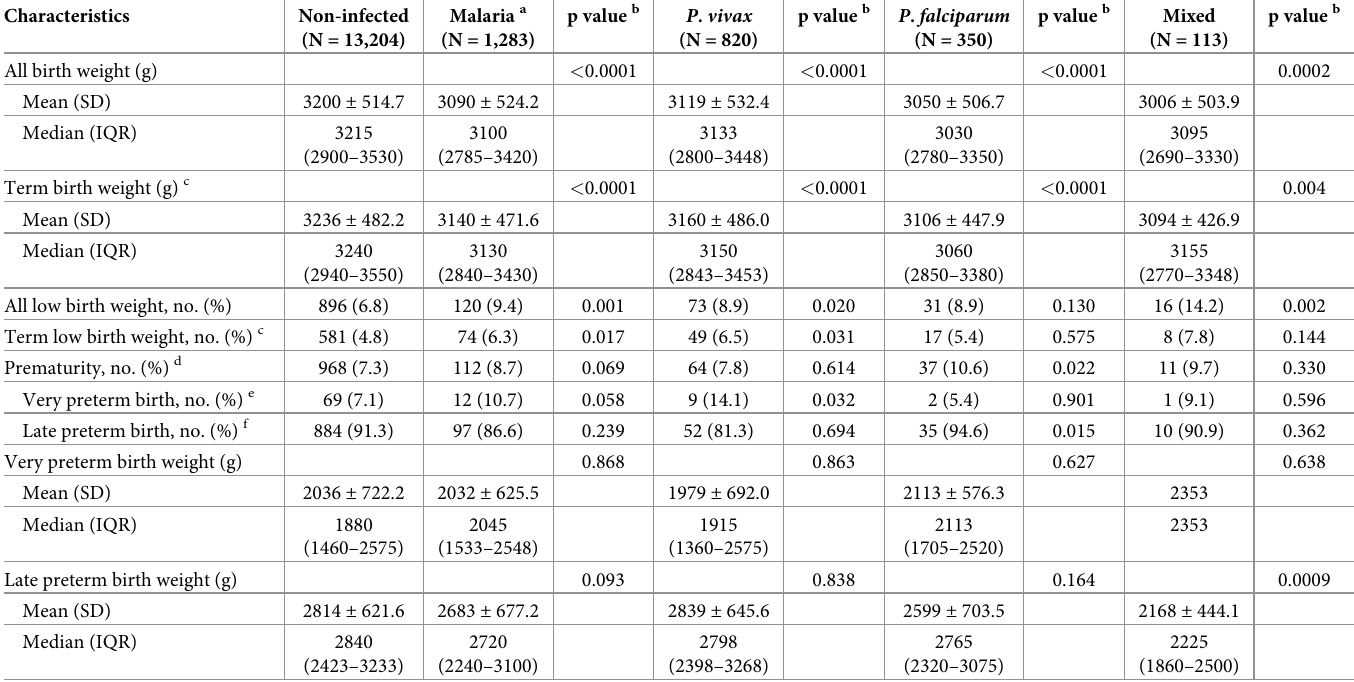
Table 2. Clinical outcomes of newborns at